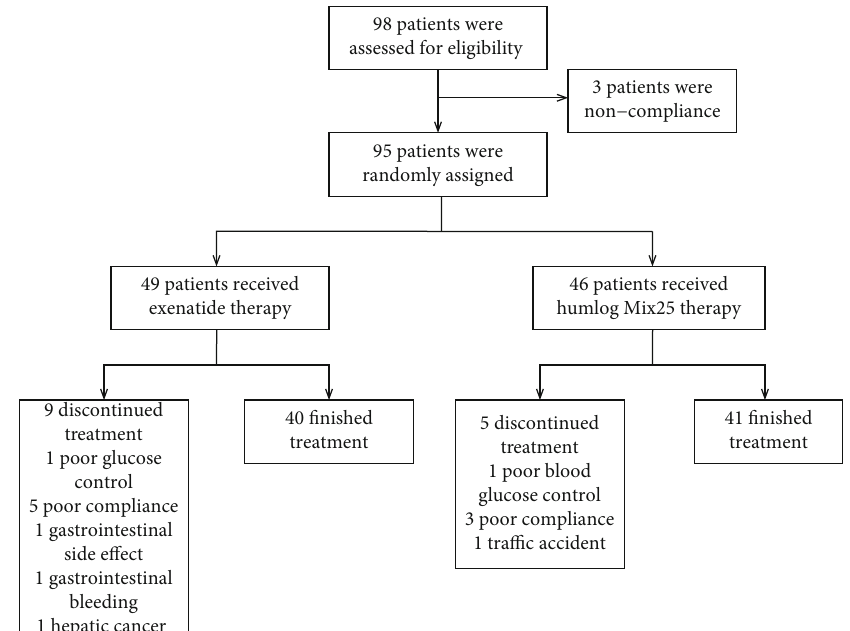
Figure 1: The patient fl ow